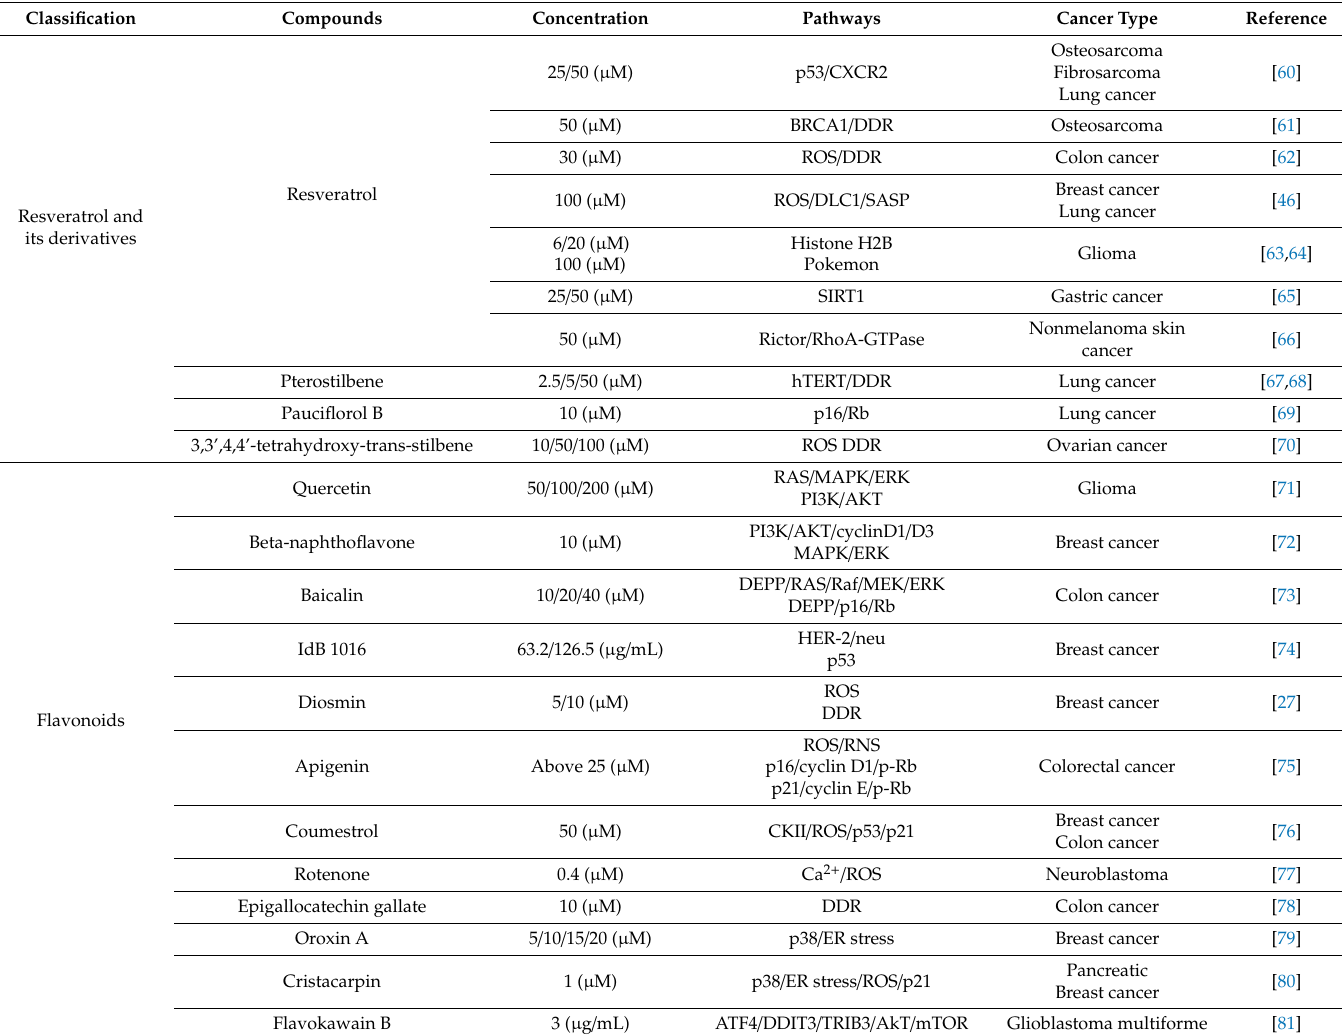
Table 1. Polyphenols and polyphenol derivatives as cancer cell senescence inducers and their e ff ect on signal transduction